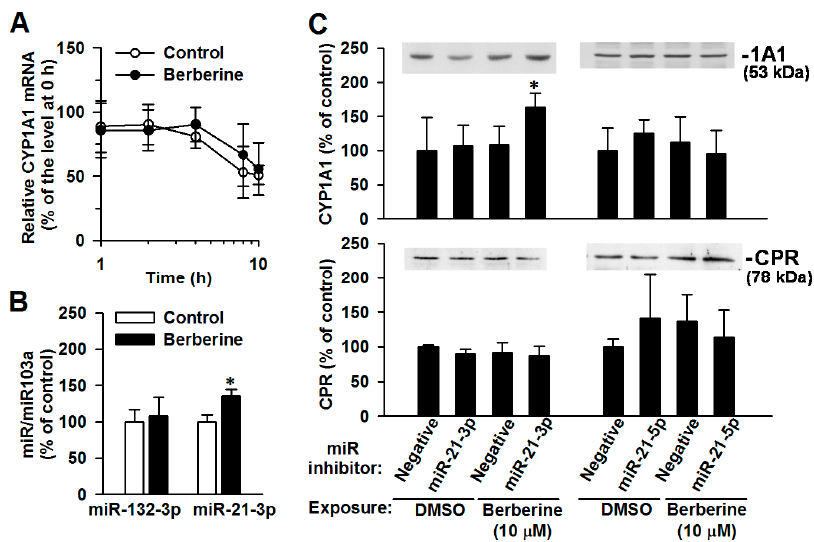
Figure 5. Effects of berberine on the CYP1A1 mRNA degradation ( A ) and miR levels ( B ), and the effects of miR inhibitors on CYP1A1 protein levels ( C ) in control and berberine-treated MCF-7 cells. Cells were exposed to vehicle (control) and berberine (10 μ M) for 24 h. ( A ) Cells were exposed to actinomycin for 1, 2, 4 and 8 h and then total RNA was isolated. CYP1A1 mRNA level was determined using RT-PCR analysis followed by gel electrophoresis. Results represent the mean ± SD of 3 experiments. ( B ) The miR levels were determined using real-time PCR analysis. Results represent the mean ± SD of 4 separate experiments. * p < 0.05, compared with control cells. ( C ) After transfection with miR inhibitors for 48 h, cells were exposed to berberine for 24 h. Cell lysates were prepared and subjected to immunoblot analysis of CYP1A1 and CPR. The representative blots are shown on the top of the results of relative band-intensity determination. The band intensity of the DMSO-treated cells with the negative transfection was considered as 100%. Results represent the mean ± SD of 3 separate experiments. * p < 0.05, compared with respective negative transfection control with the same chemical exposure.